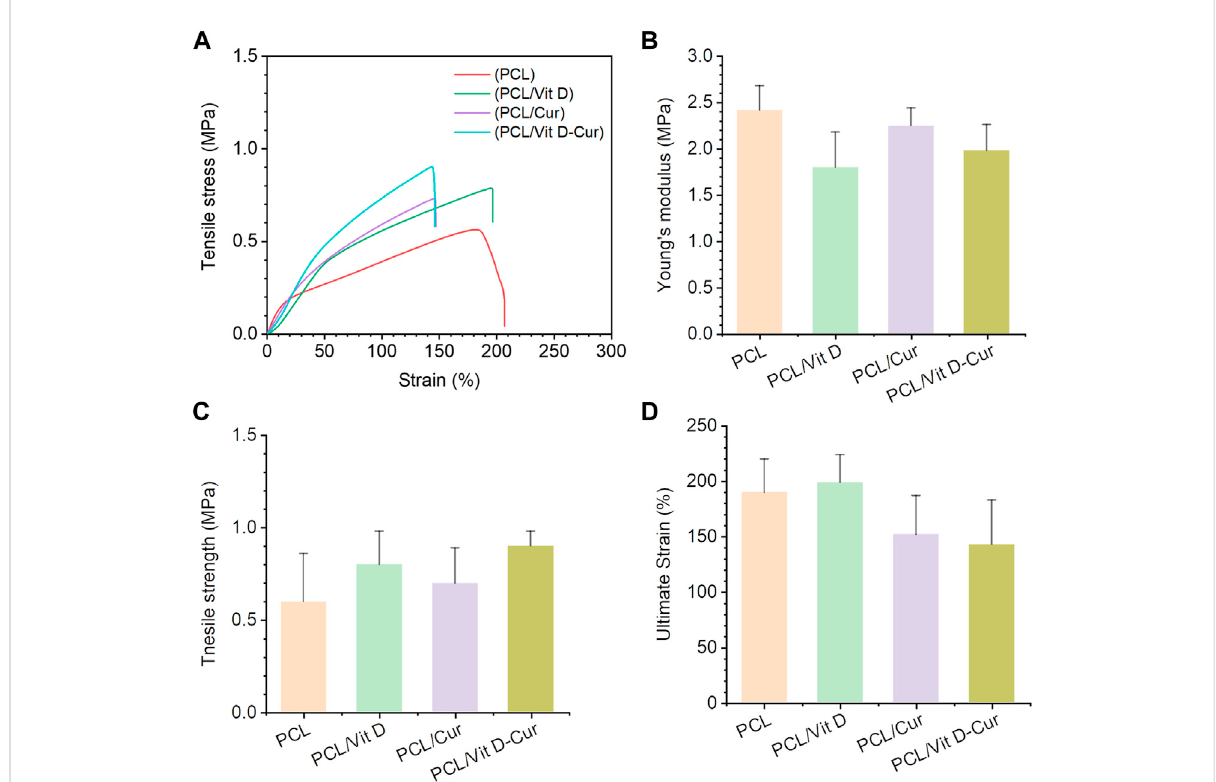
FIGURE 4 Mechanical characterization of PCL, PCL/Vit D, PCL/Cur, PCL/Vit D-Cur scaffolds (A) representative stress-strain curves of scaffolds recorded from a tensile test; (B) Young ’ s modulus, (C) tensile strength, and (D) ultimate strain calculated from the stress-strain curves. Error bars represent mean ± SD for n = 3.